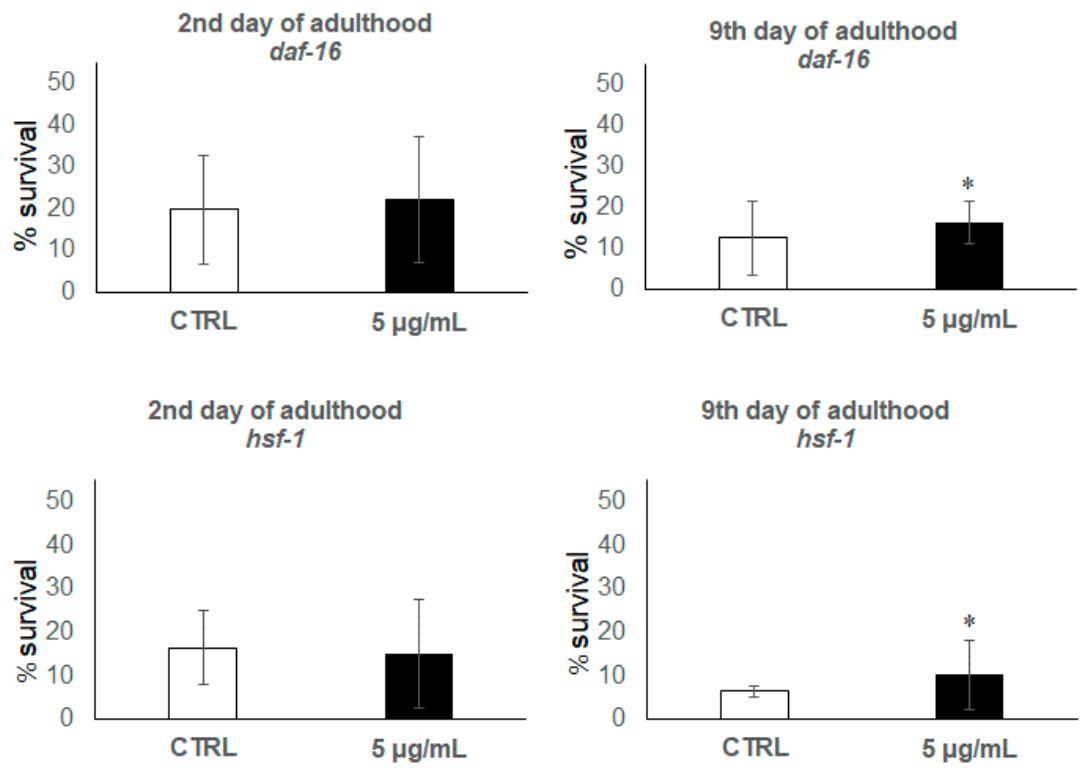
Figure 6. Percentages of worm survival at the 2nd and 9th day of adulthood after the application of thermal stress (35 ◦ C, 8 h) in the C. elegans mutant strains daf-16 and hsf-1 grown in the absence (controls) and presence of 5 µ g / mL of the bilberry anthocyanin extract. The results are presented as the mean values ± SD. The asterisk indicates a significant difference in relation to controls at p < 0.05.